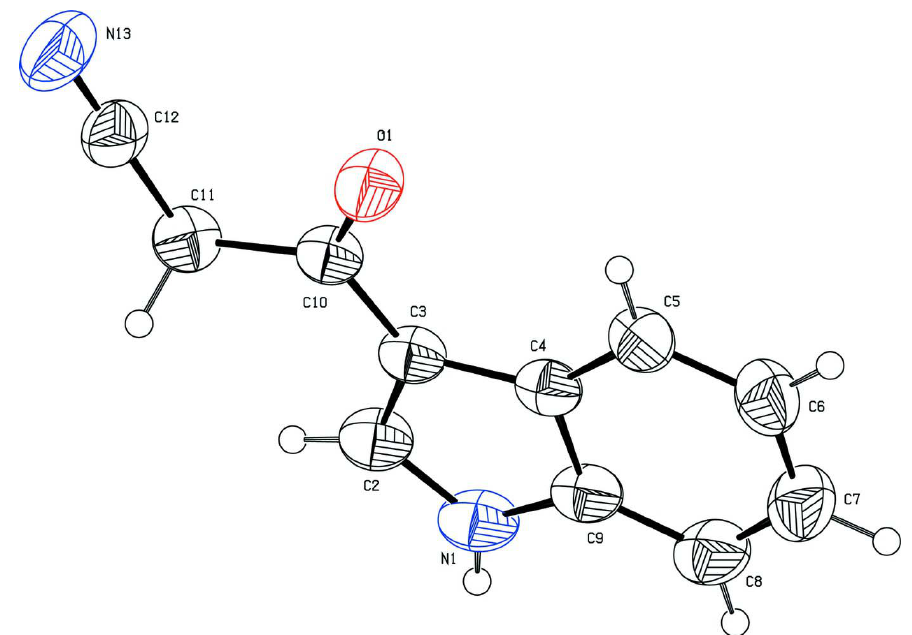
Figure 1 Perspective view of the molecule showing the thermal ellipsoids are drawn at 50% probability level. The H atoms are shown as small circles of arbitrary